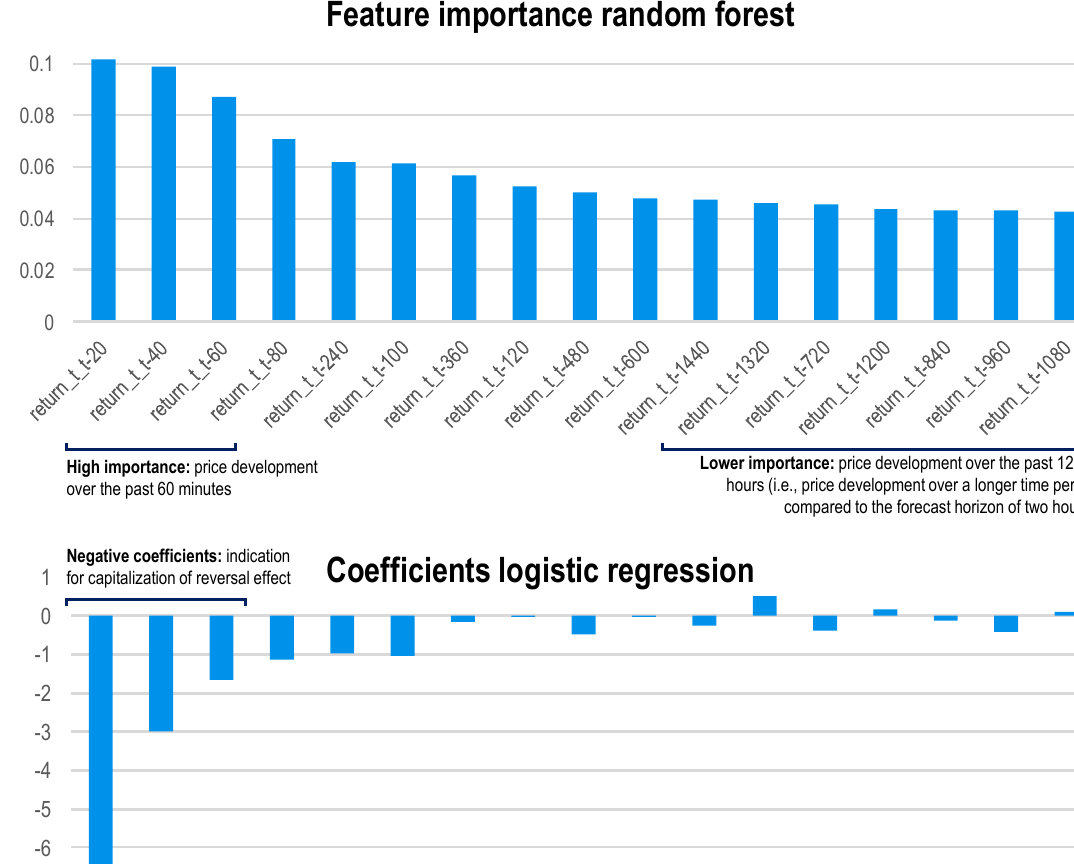
Figure 2. Feature importance extracted from the random forest and regression coefficients for the logistic regression model. The features (explanatory variables) are sorted in descending order based on their importance extracted from the random forest model. The coefficients of the logistic regression model are plotted following the same